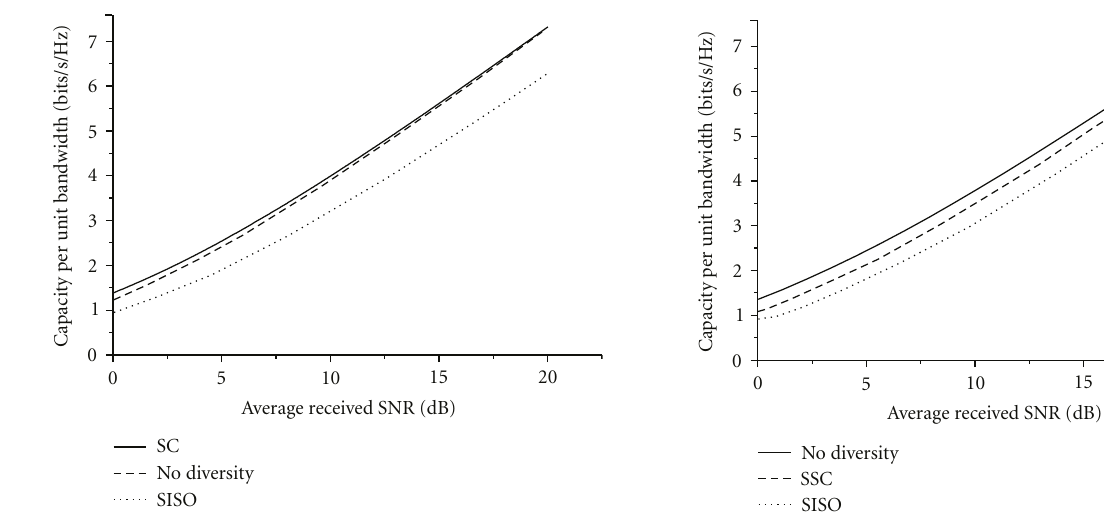
Figure 4: Capacity per unit bandwidth of a dual branch Nakagami- m fading channel with SSC diversity as a function of the average received SNR.